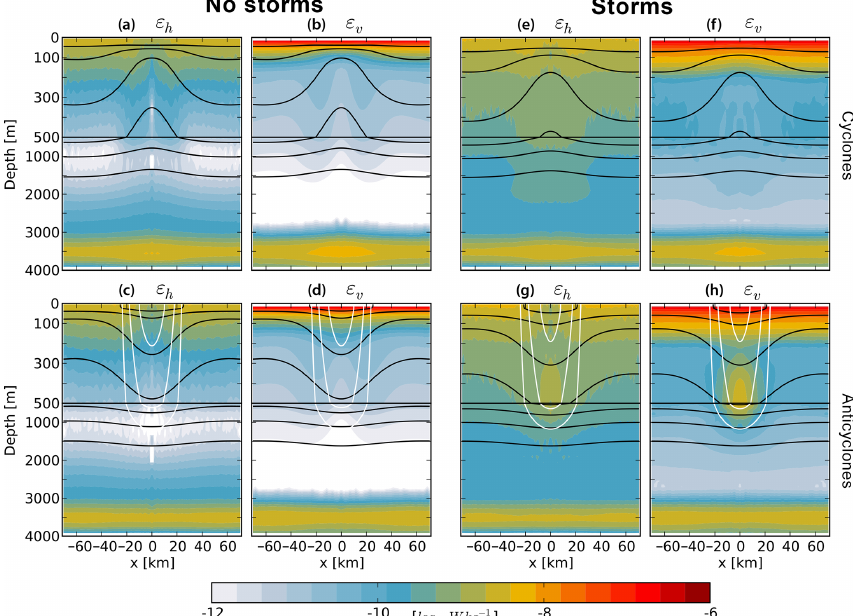
Figure 12. ε h and ε v (Wkg − 1 ) distribution within composite cyclones (top) and anticyclones (bottom) identified in the 2km experiments without storms (left) and with storms (right). The black iso-contours are isotherms from 2 to 8 ◦ C and σ/f iso-contours are shown in white (0.9, 0.95 and 0.98 σ/f ) , with σ = f + ξ/ 2 the effective frequency and ζ the relative vorticity. Composites are built using 10 years of 5- day-averaged model outputs, between L y / 3 and 2 L y / 3. A total of 8167 cyclone and 8878 anticyclone snapshots have been identified in the experiment without storms and 7306 cyclone and 8037 anticyclone snapshots in the experiment with